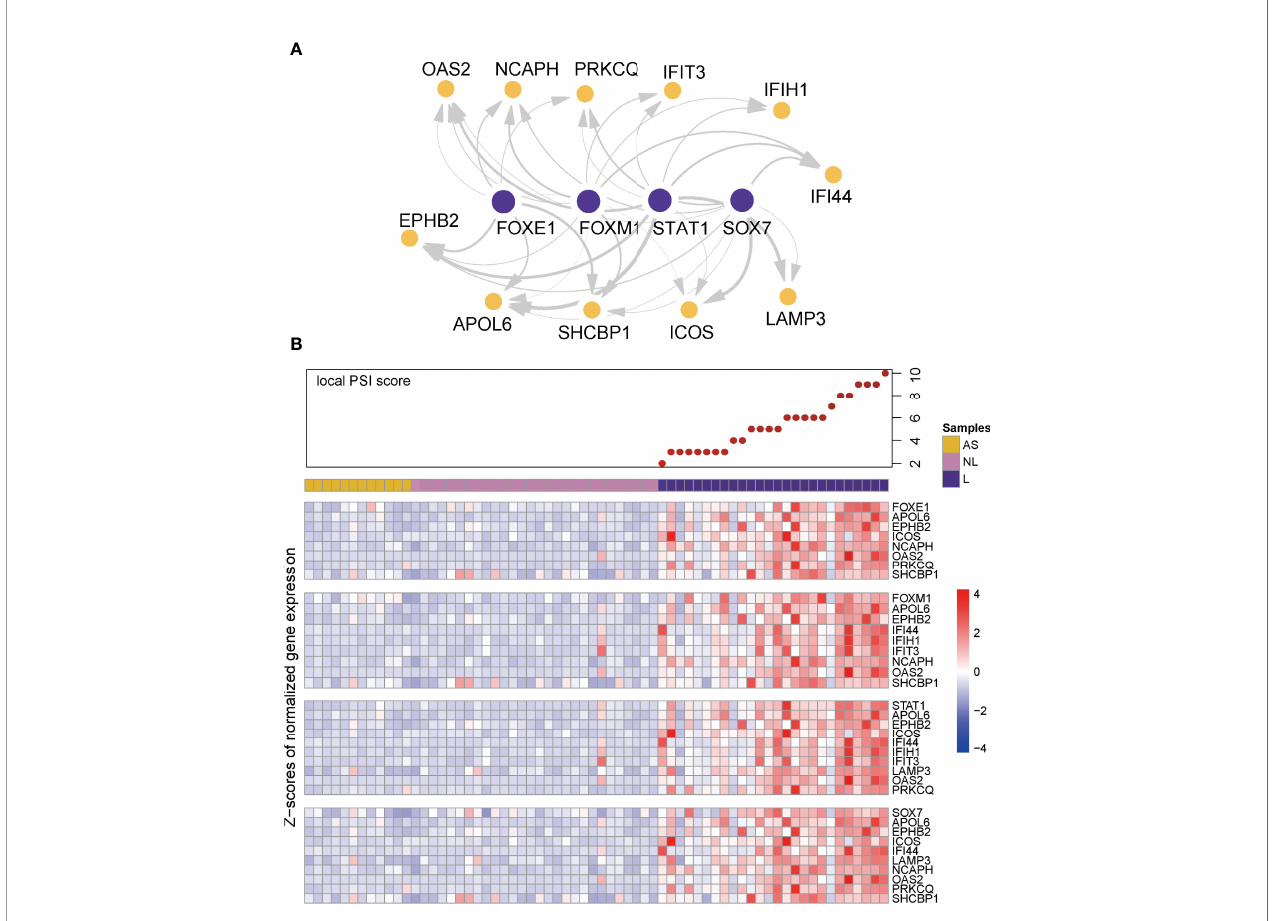
FIGURE 5 | Visualization of gene regulatory network and co-expression pattern. (A) Visualization of gene regulatory network in psoriasis. Edge width represents the weight of each connection. (B) Local PSI score and heatmaps of co-expression pattern of key regulators ( fi rst row of each heatmap panel) and their target genes across all the samples in the validation